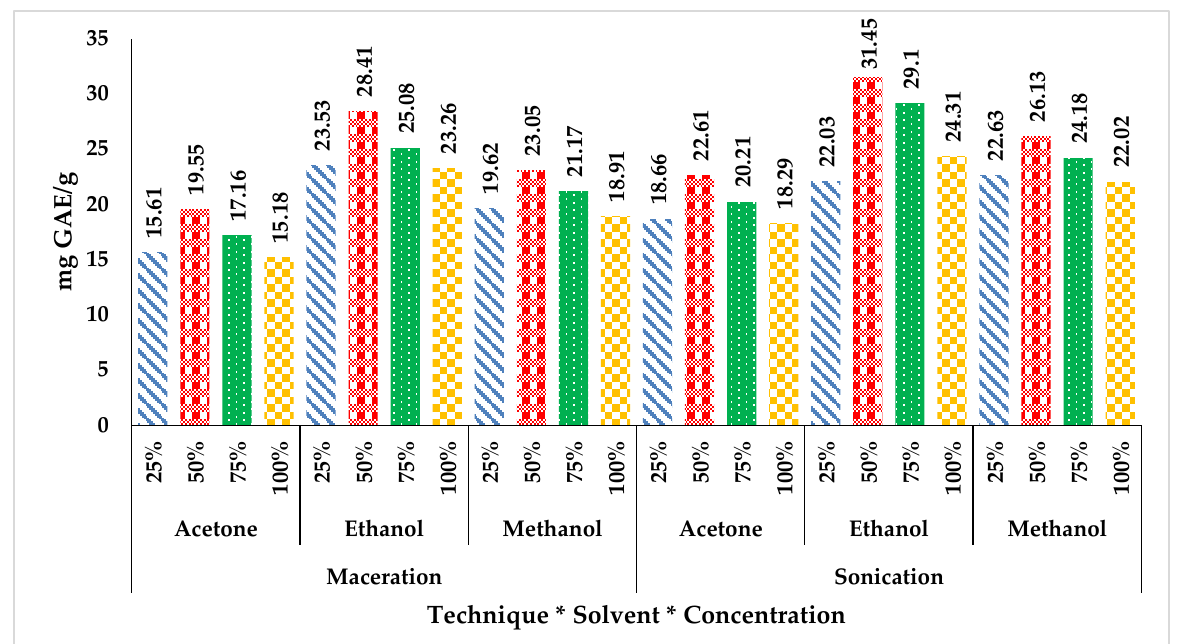
Figure 3. TPC of banana peel extracts.